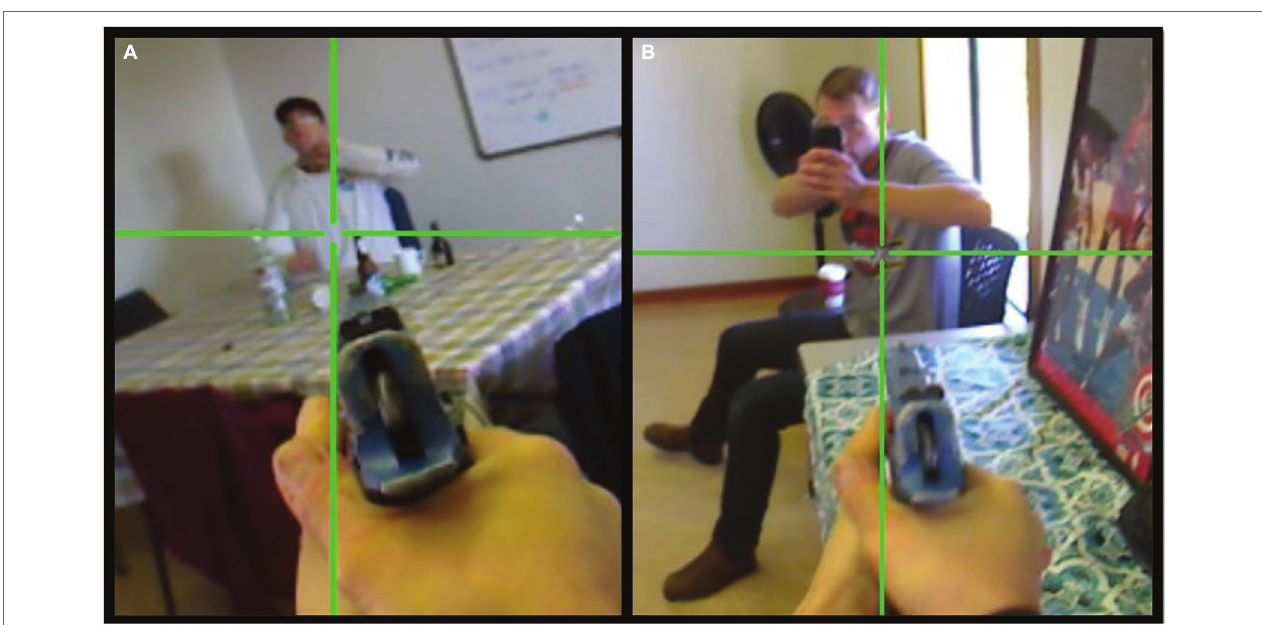
FIGURE 5 | Lethal force errors during the scenario. (A) Shooting the subject while they were armed with a knife and exhibiting a threat of self-harm (i.e., decision- making error); and (B) shooting the bystander holding a cell phone (i.e., mistake of fact error). Green crosshairs represent participant gaze (from eye-tracker) at central mass while pulling the trigger.